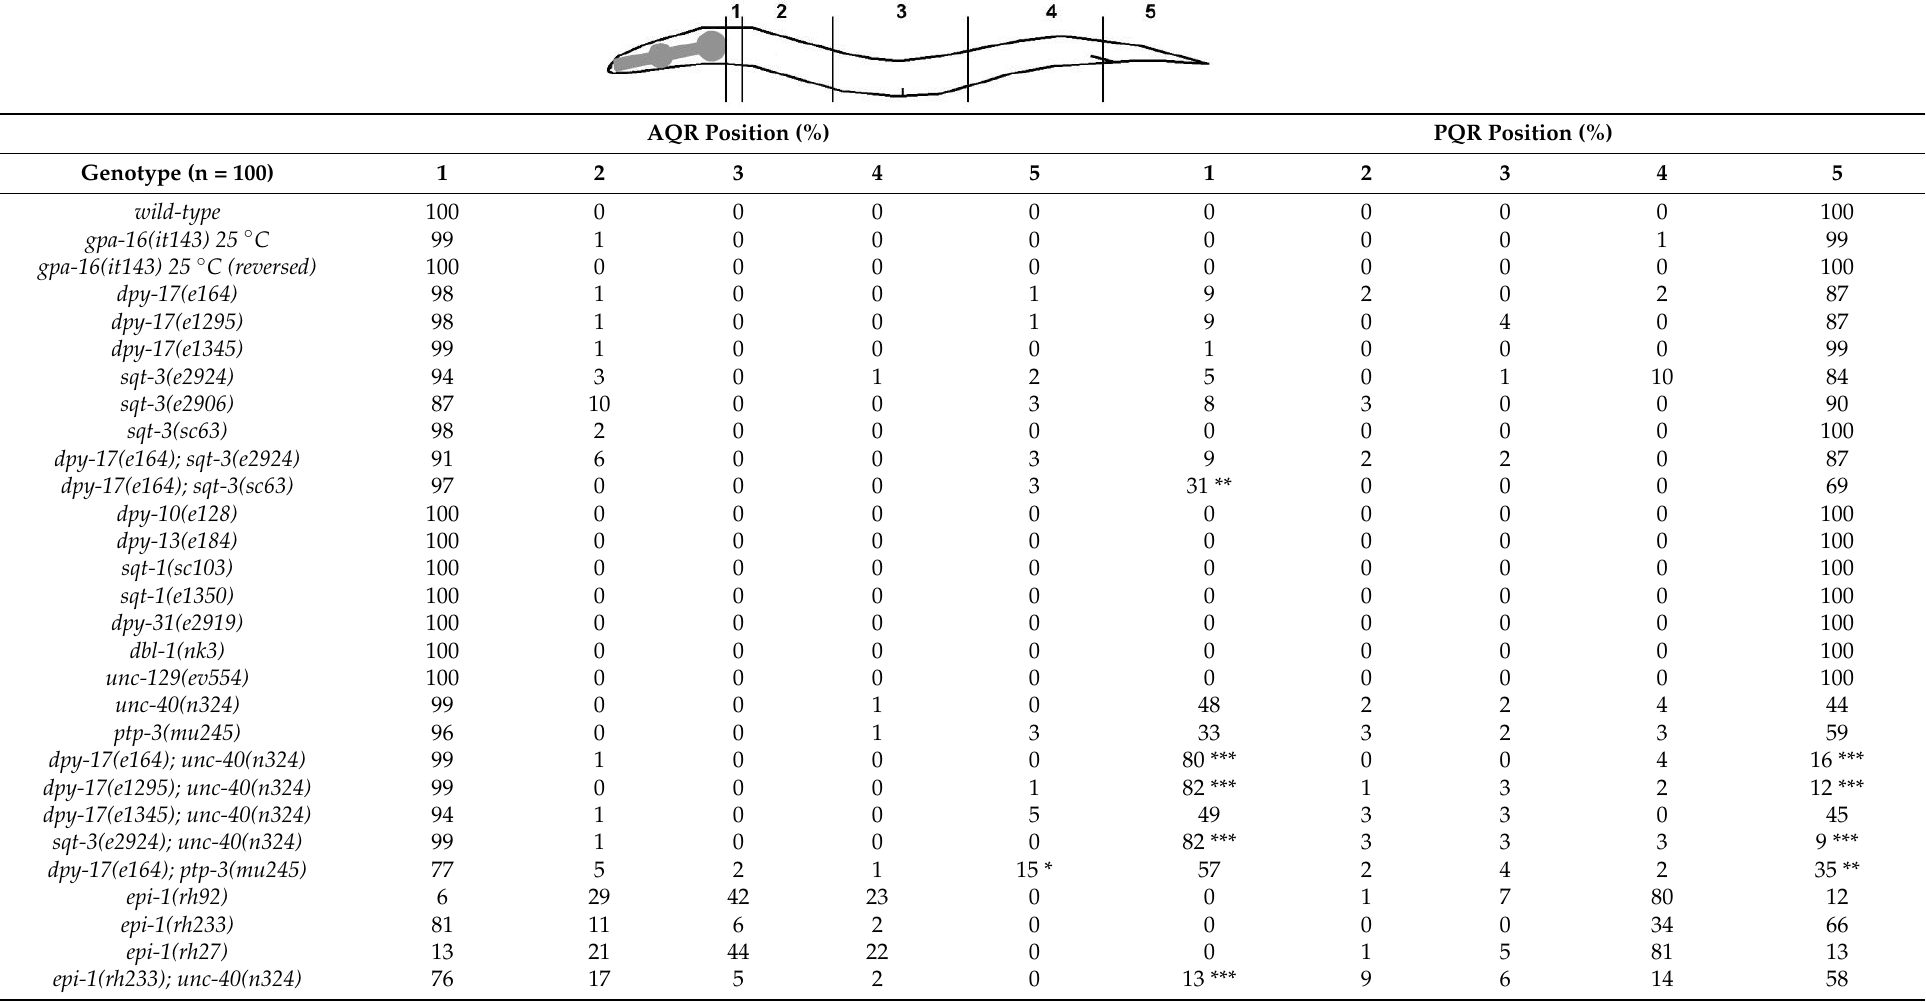
Table 1. AQR and PQR migration defects.